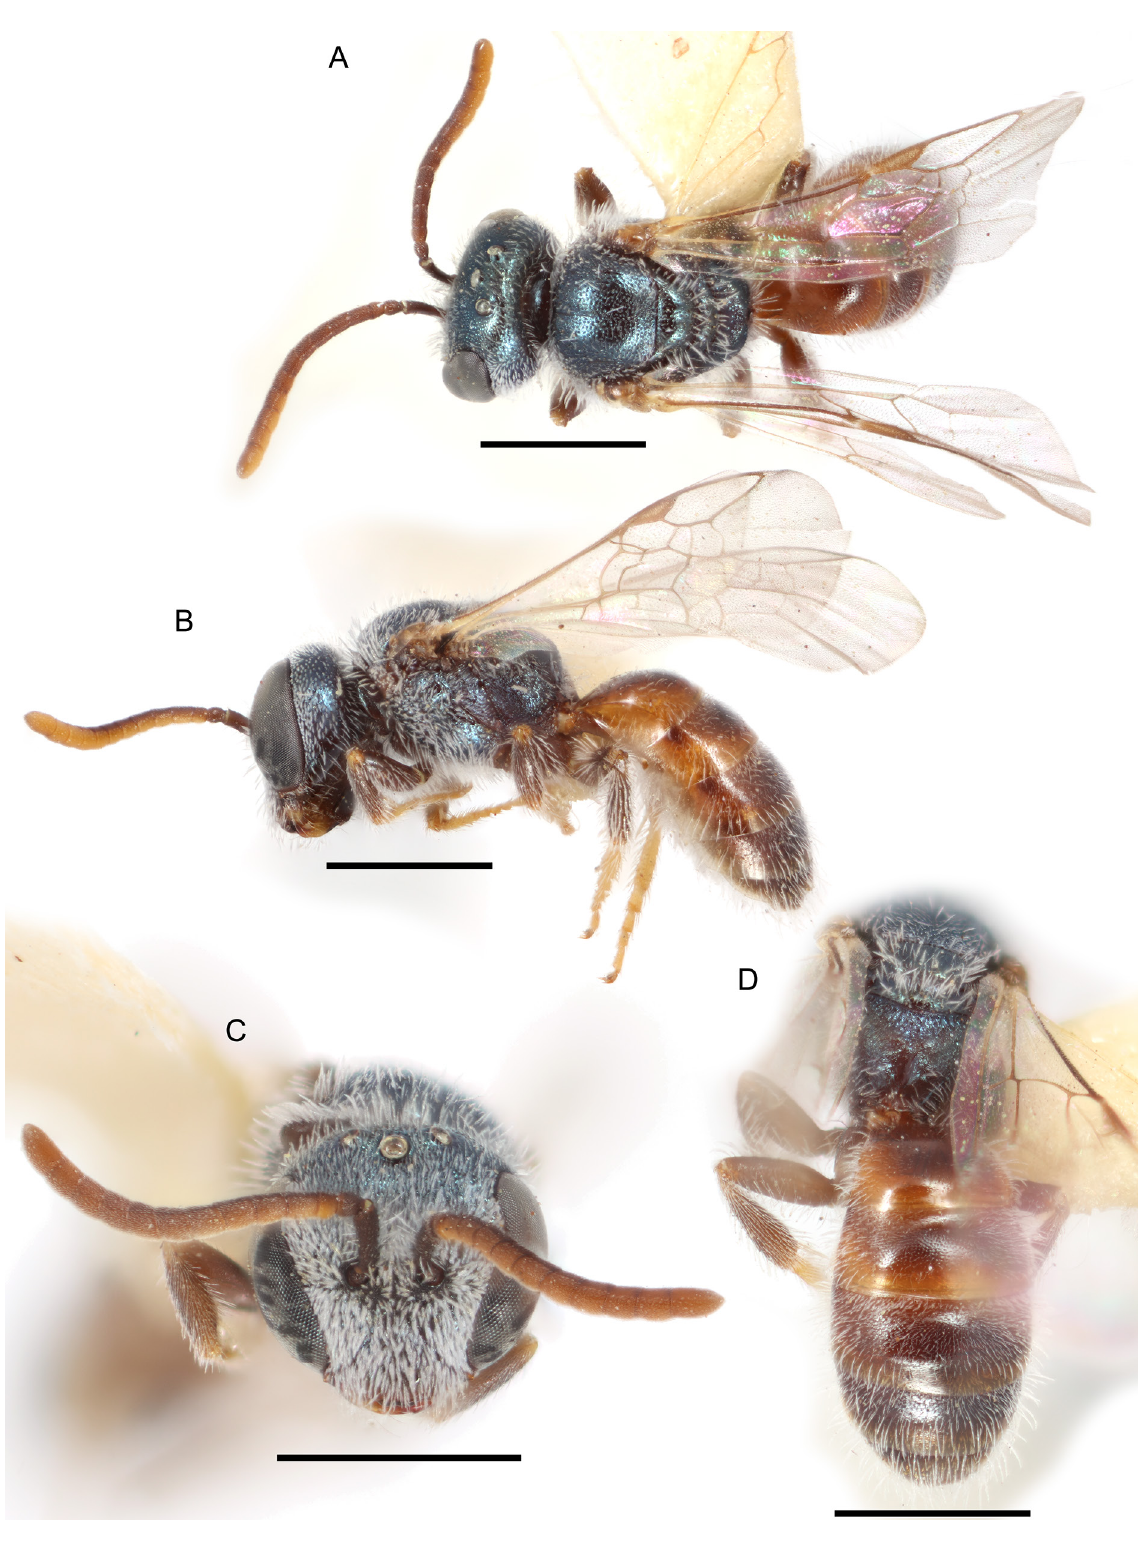
Fig. 44. Lasioglossum ( D. ) imbriumbrae sp. nov., ♂. A . Dorsal habitus. B . Lateral habitus. C . Face. D . Propodeum and metasoma. Scale bars: 1